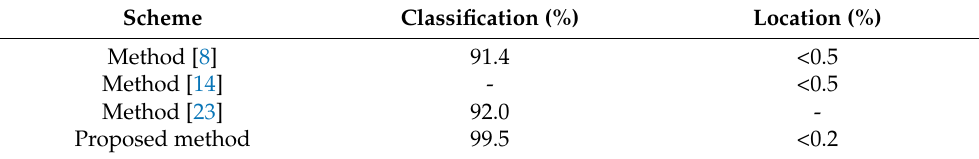
Table 21. Scheme